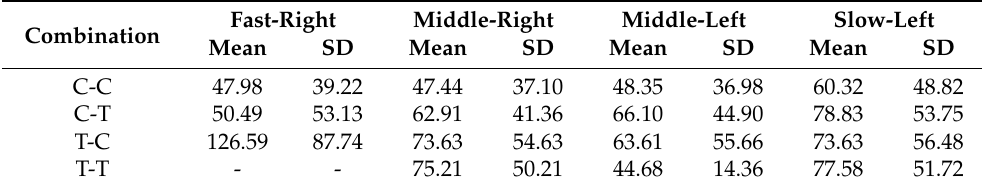
Table A6. The mean and standard deviation of ∆ D of m and n2.